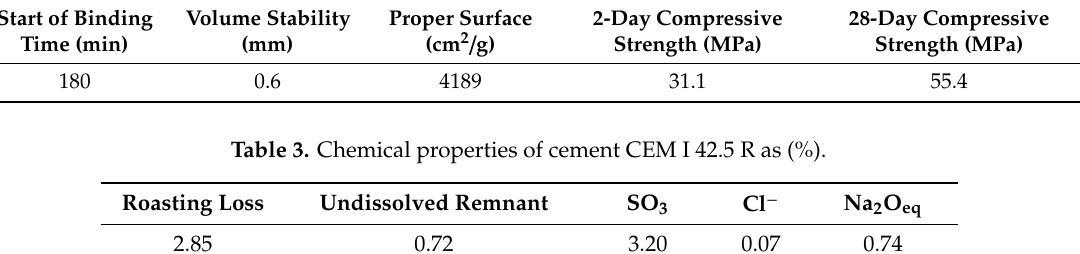
Table 2. Physical and mechanical properties of cement CEM I 42.5 R.